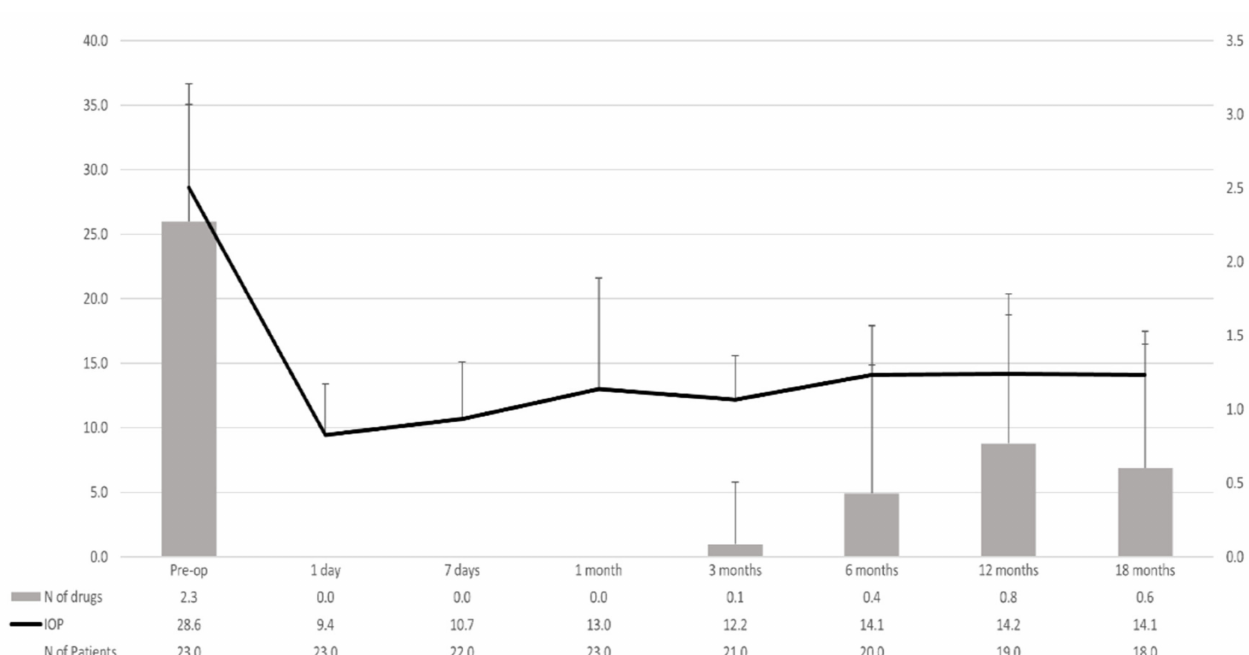
Figure 1. Mean intraocular pressure (IOP) and number of ocular hypotensive medications throughout study follow-up in the overall study population. Vertical bars represent standard deviation.